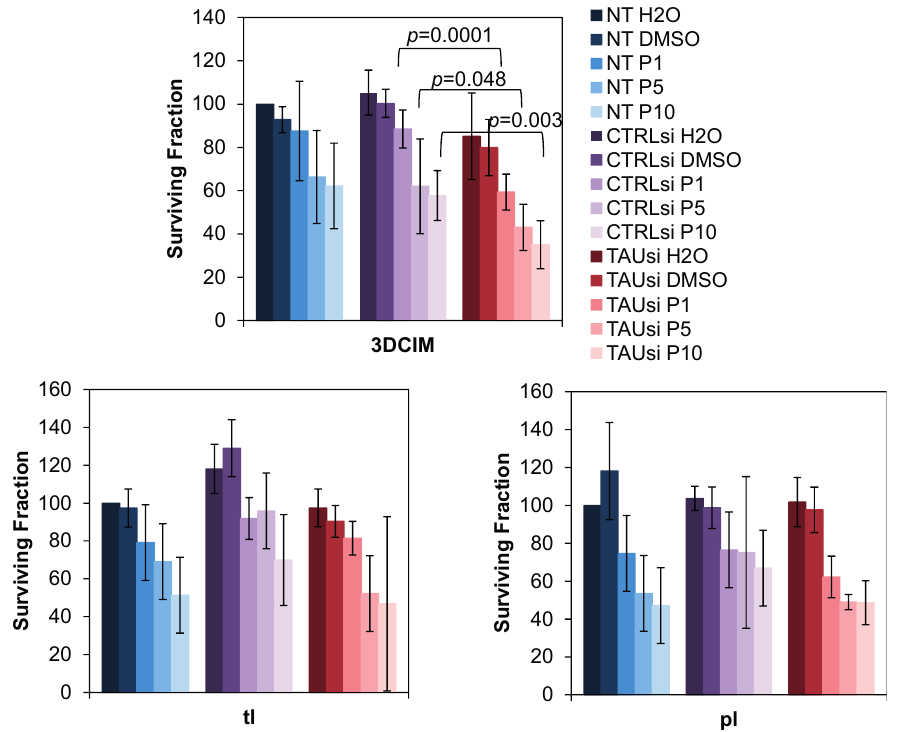
Figure 4. Down-regulation of tau reduces cell survival of SKOV-3 cultured atop three-dimensional collagen type I matrix. Cells were transiently transfected with either control (CTRLsi) or Tau-specific (TAUsi) siRNA, or non-transfected (NT) for three days, then replated atop three-dimensional collagen type I matrix (3DCIM), thin layer coated collagen type I (tl), and plastic supports (pl), treated with paclitaxel at 1, 5, and 10 nM (designated P1, P5, and P10, respectively), as well as H 2 O or DMSO as a controls for 24 h. Cells that survived the treatment were collected and counted. Cell numbers collected from non-transfected H20-treated controls (NT H 2 O) were arbitrarily set as “100”, and cell numbers for all other conditions were recalculated and plotted